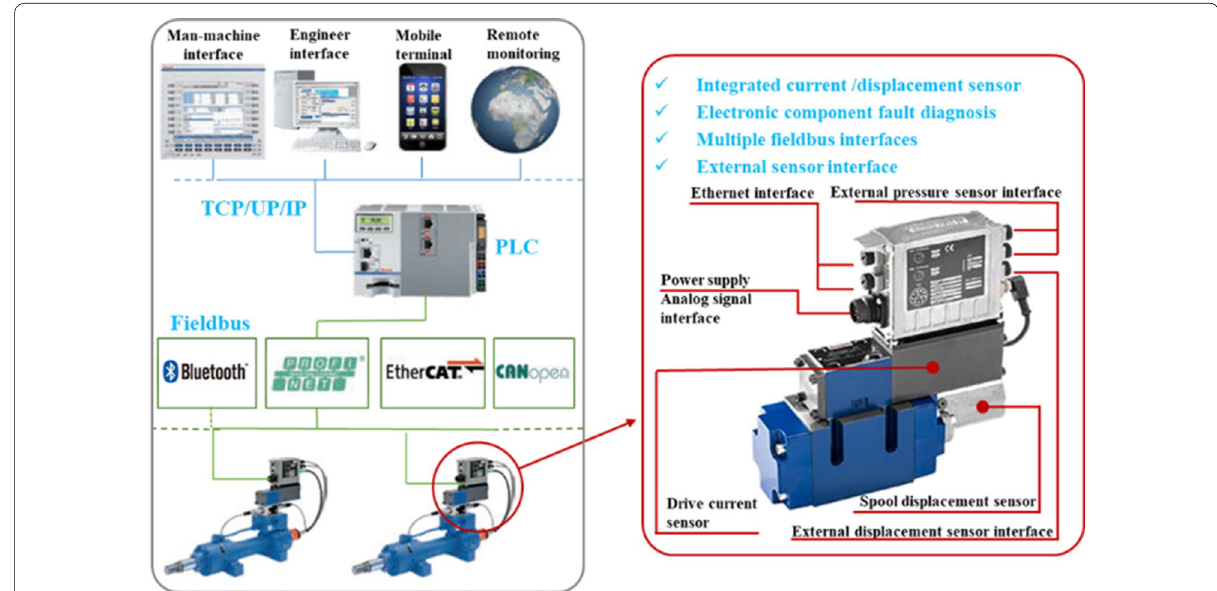
Figure 2 State acquisition and transmission